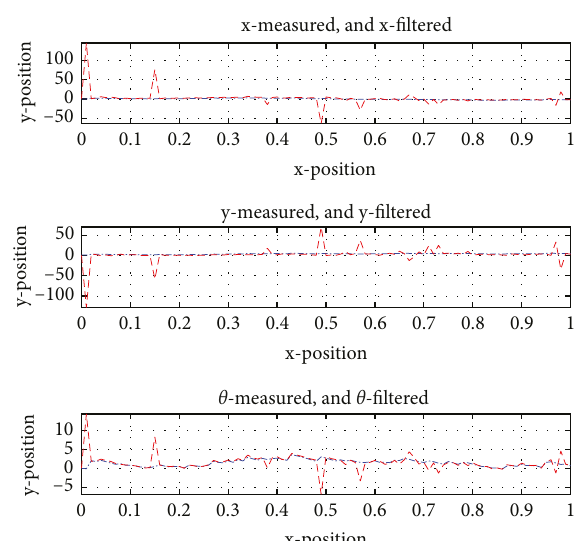
Figure 5: EKF performance with one landmark and non-Gaussian noise.